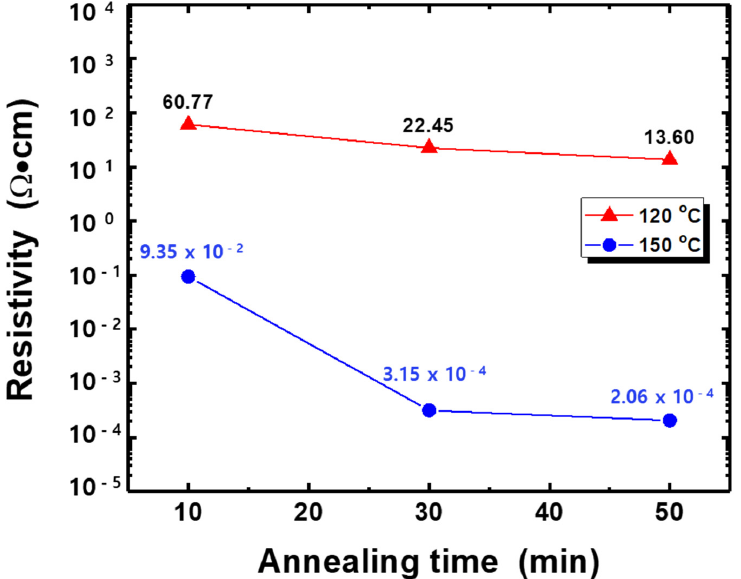
Figure 6. Electrical resistivity of silver thin films thermally treated at different temperatures and for various durations. The film thickness was about 700–800 nm.